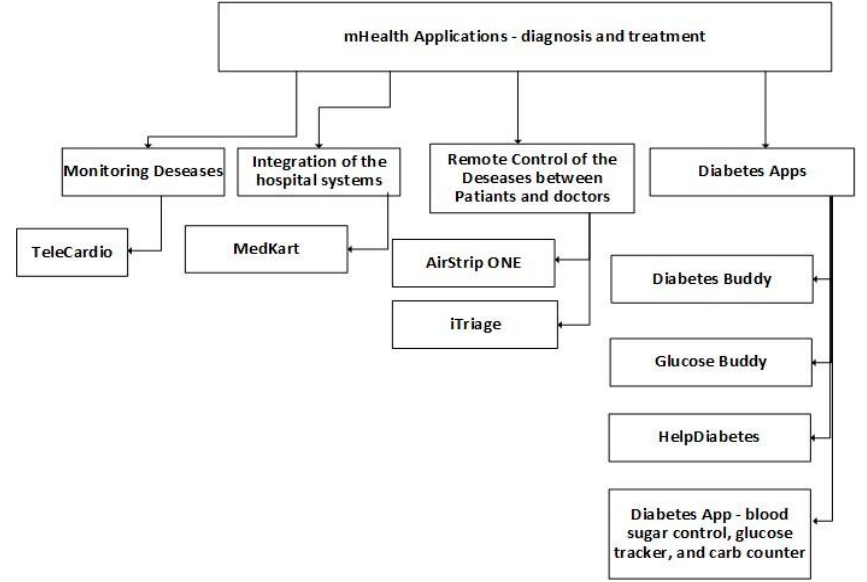
Figure 8. Classification of mobile health applications related to diagnosis and treatment.